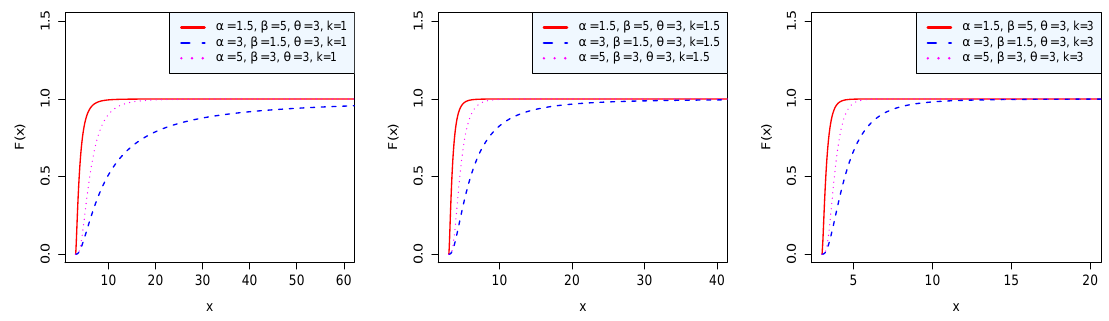
Figure 3. Cumulative distribution function of the BP distribution.